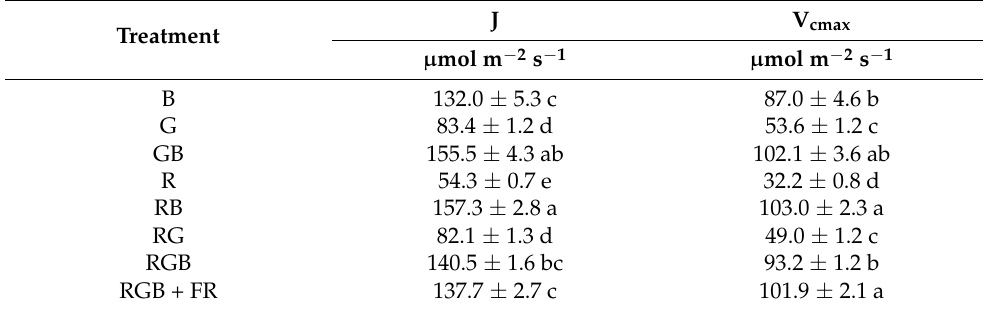
Figure 1. Net photosynthesis (A) vs. cellular CO 2 concentration (C c ) curve fitting for each light treatment. Filled circles represent observed net photosynthesis (A) relative to calculated Cc values. The solid line shows Rubisco limitation, while the dotted line fits RuBP limitation. Triose-phosphate utilization (TPU) limitation was not apparent. Table 1. Maximum carboxylation rate of Rubisco (Vcmax) and potential rate of photosynthetic electron transport (J) estimated for each light treatment. Different letters indicate significant differences ( p ≤ 0.05; n = 3 or 4).